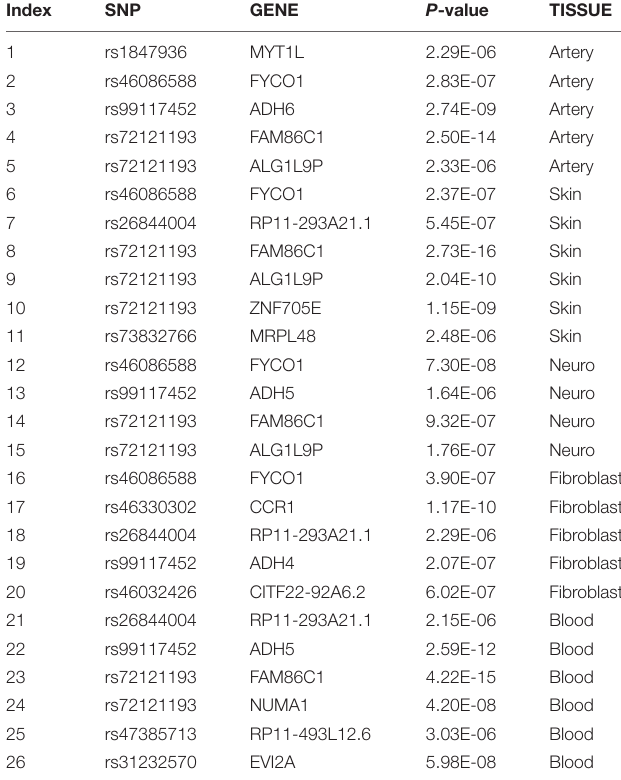
TABLE 2 | Information table of SNP-Gene pairs selected by different